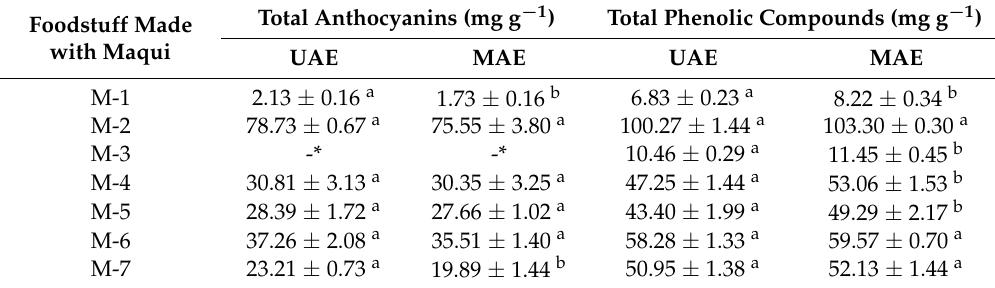
Table 4. Total anthocyanins (mg g − 1 ) and total phenolic compounds (mg g − 1 ) extracted for each commercial samples by means of ultrasound assisted extraction (UAE) and microwave assisted extraction